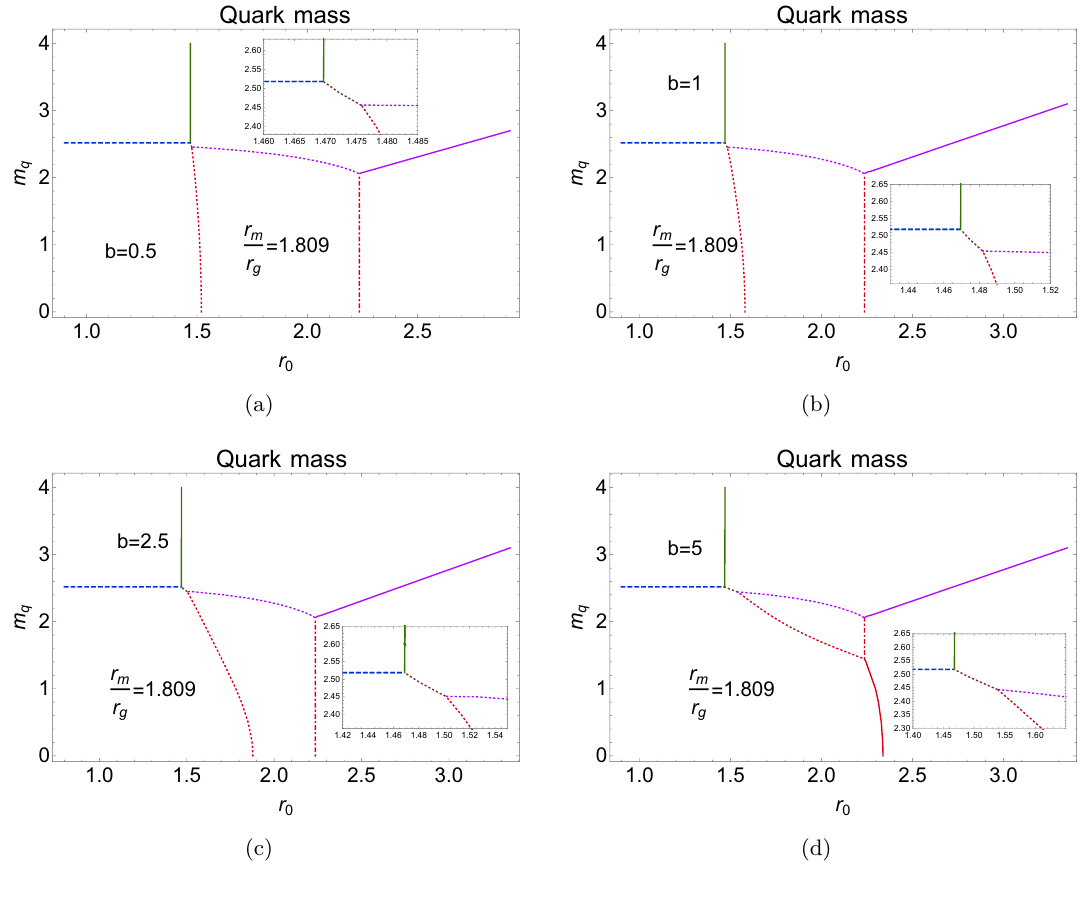
Figure 11 . Large Ratio r m